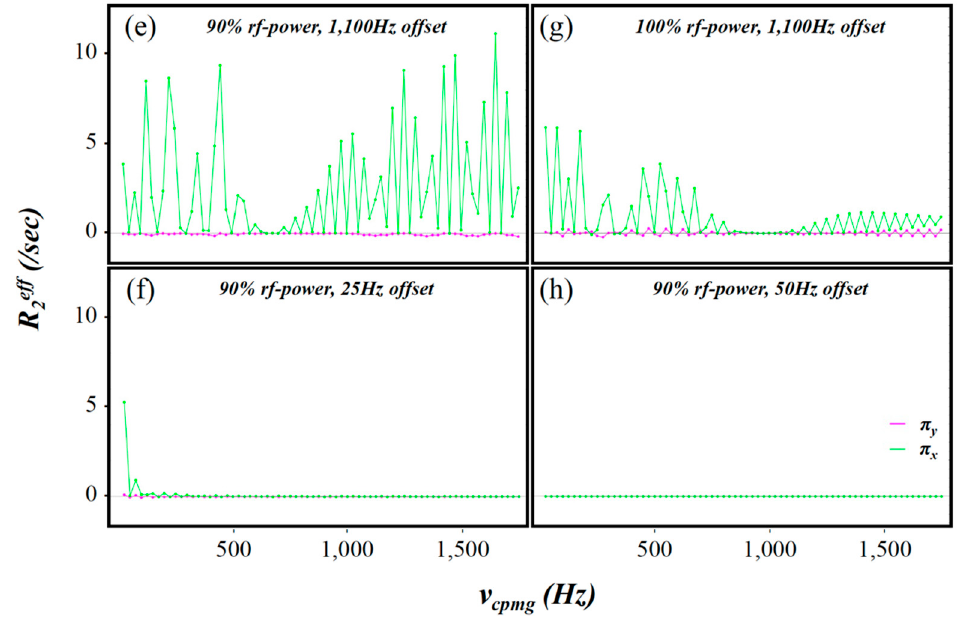
Figure 4. A simulation of artifacts occurring in rc CPMG experiments. Magnetization 2 S y I z was allowed to evolve during CPMG 1 , U-element, and CPMG 2 periods. ( a – d ) The normalized peak intensities of the TROSY magnetization component S x I β are plotted as a function of the S spin resonance offset ranging from − 1500 to 1500 Hz at intervals of 3.0 Hz. The simulation assumed that the S and I spins have no intrinsic R 1 or R 2 relaxation and no exchange contribution to apparent R 2 . Spin-echoes were repeated n times during each CPMG constant time period of 20 ms (solid magenta line: n = 1 ( ν cpmg = 25 Hz), dashed blue line: n = 2 ( ν cpmg = 50 Hz), and dotted green line: n = 40 ( ν cpmg = 1000 Hz)). The CPMG π pulses were applied with a width of 80 µ s with a phase of y and x during the CPMG 1 and CPMG 2 periods, respectively. In ( a , b ), the rf field strength for spin S was set to the value exact on resonance (i.e., 6250 Hz). In ( c , d ), the rf field strength was reduced by 10% without changing the pulse width. Thus, the timing of all pulses and delays was the same in all four cases. Furthermore, in ( a , c ), the phase of the S spin π pulse in the U-element was cycled as { y , − y }, and each pair of intensities was averaged. In ( b , d ), the corresponding phase was cycled as { x , − x }, and each pair of intensities was averaged. The pulse length and rf field strength for spin S in the U-element were set to the same values as those in the CPMG periods. The 1 H π pulses in the U-element were applied with a length of 20 µ s with the power exact on resonance (25 kHz). The 1 J coupling constant between spins S and I was set to 100 Hz. ( e – h ) Simulated rd curves for the rc CPMG pulse sequence with the S spin π pulse phase in the U-element set to y (magenta) and x (green) are compared. The magnitude of the final TROSY magnetization component S x I β ( I cpmg ) was calculated in the same way as in ( a – d ). The reference magnitude ( I ref ) was also calculated without either applied CPMG period. The effective relaxation rate R 2eff was modeled as − (1/ T cpmg )ln( I cpmg / I ref ), where T cpmg was a total CPMG period of 40 ms, and R 2eff is plotted as a function of ν cpmg (1/(4 δ )). The repetition count n was incremented from 0 (reference) to 70, so that ν cpmg (= n / T cpmg ) covered a range from 0 to 1750 Hz. The S spin resonance offsets were set to 1100 Hz in ( e , g ), and 25 Hz in ( f ) and 50 Hz in ( h ). In ( e , f , h ), the rf field strength was reduced by 10% with the pulse width unchanged, compared to the exact power in ( g ). The remaining parameters were the same as those used in ( a – d ).